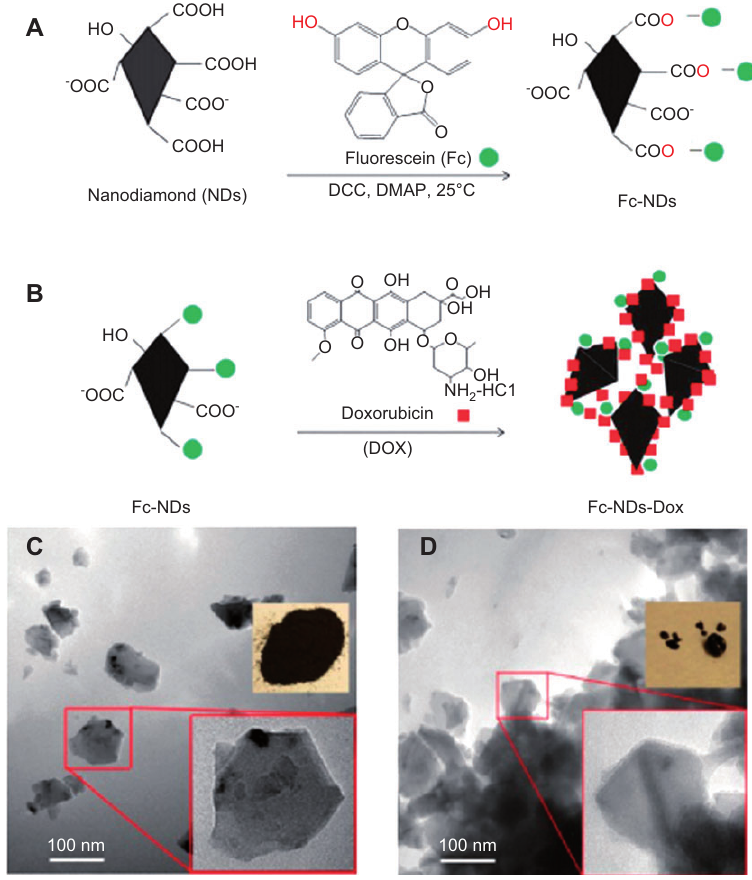
Figure 5 Preparation scheme and TEM images of ND-DOX [27]